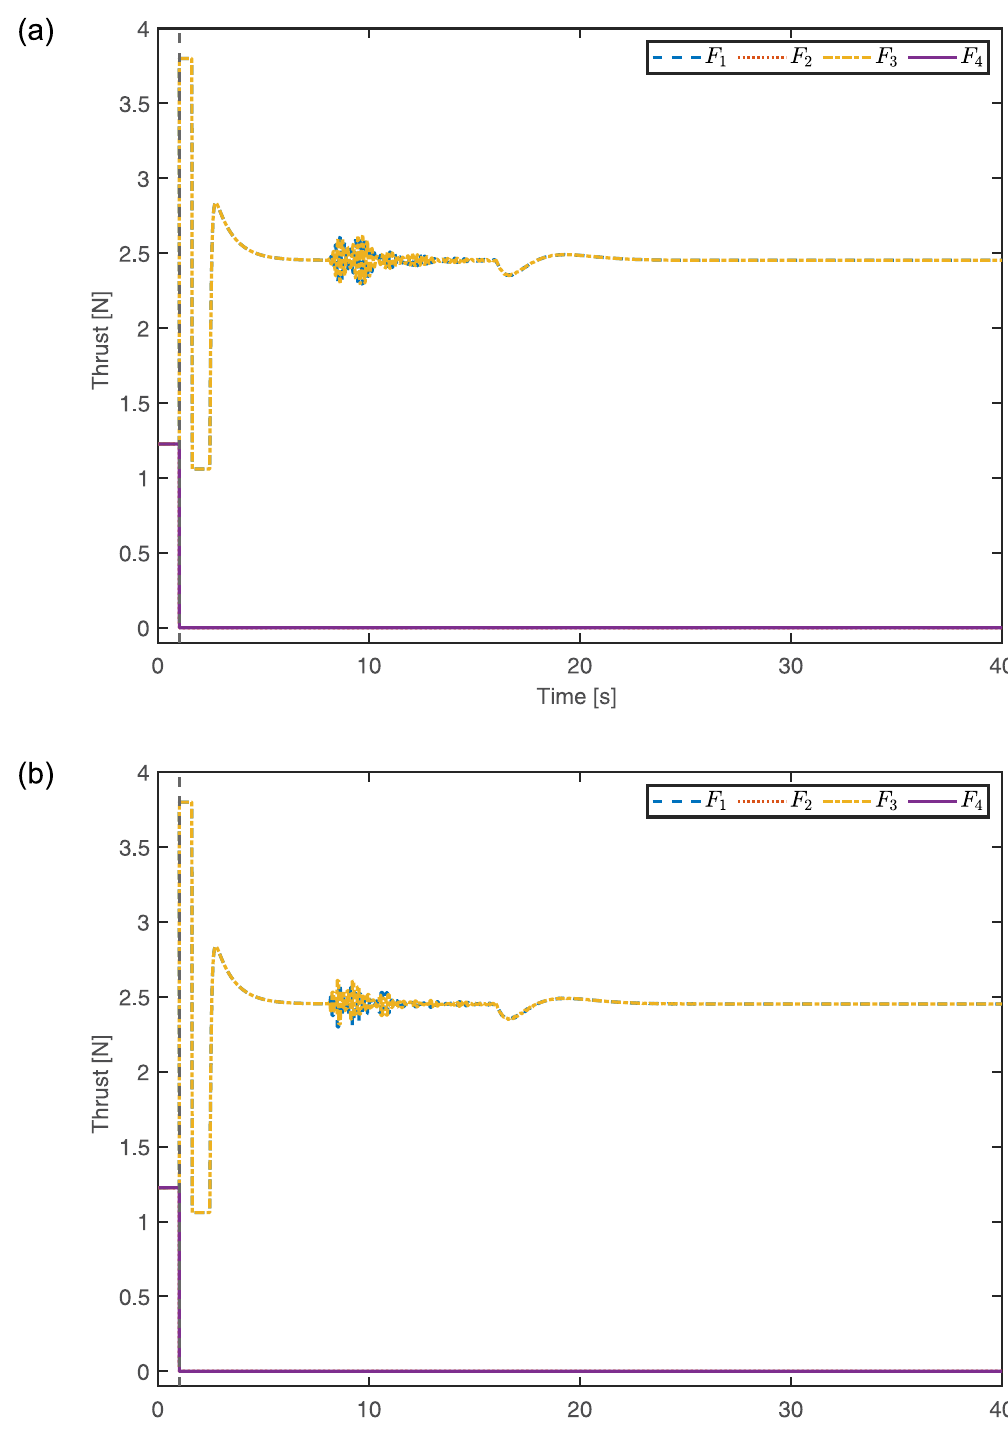
Fig 8. Motor thrusts of the quadrotor in case of Two opposing propellers’ failure. (a) Motor thrusts computed using LQI. (b) Motor thrusts computed using MPC.